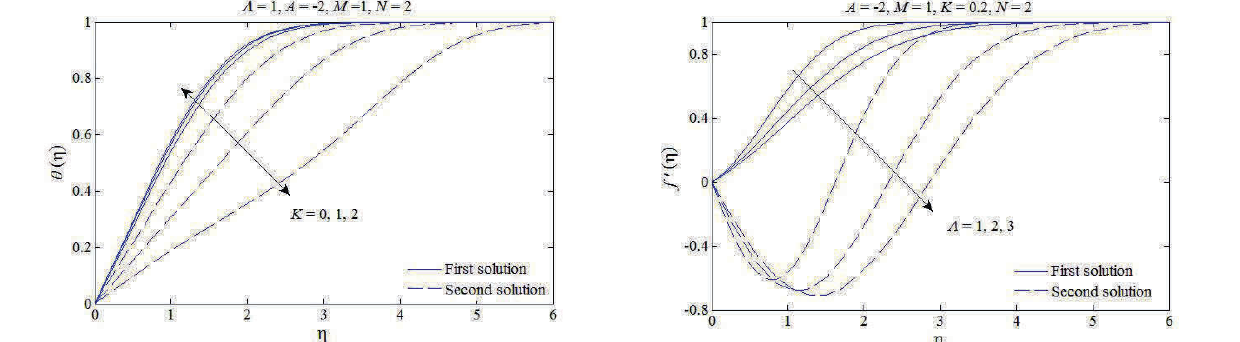
Fig. 9: Temperature profiles for different values of K .